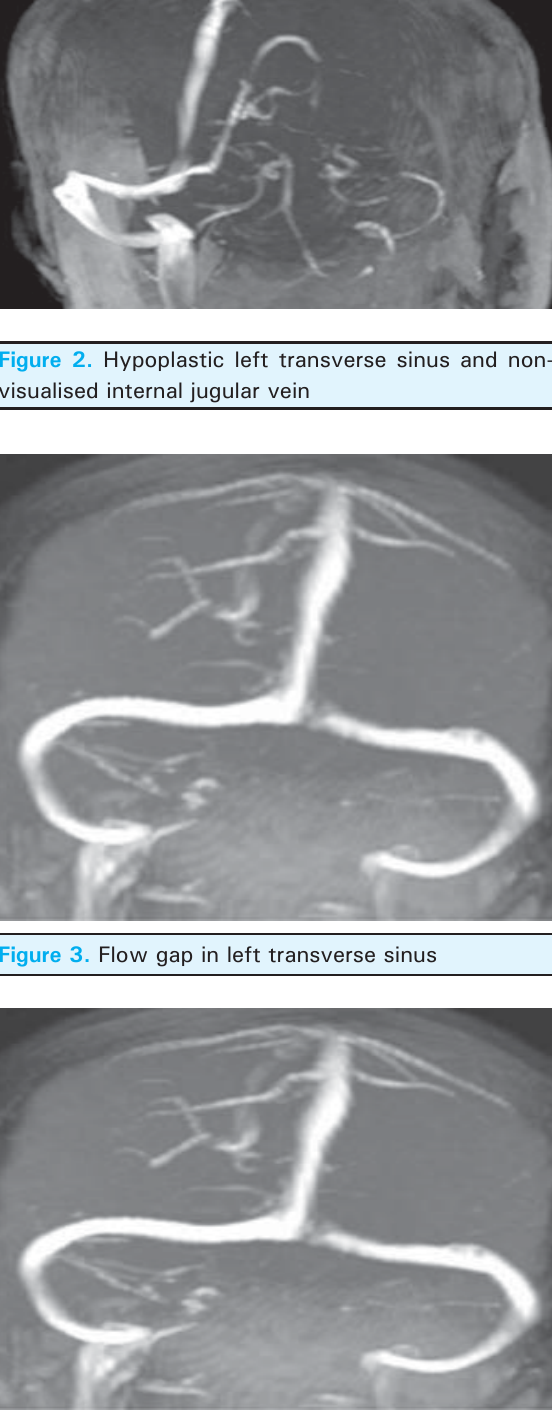
Of these, 91.4% (43/47) occurred in the non-dominant left transverse sinus, 6.3% (3/47) cases showed fl